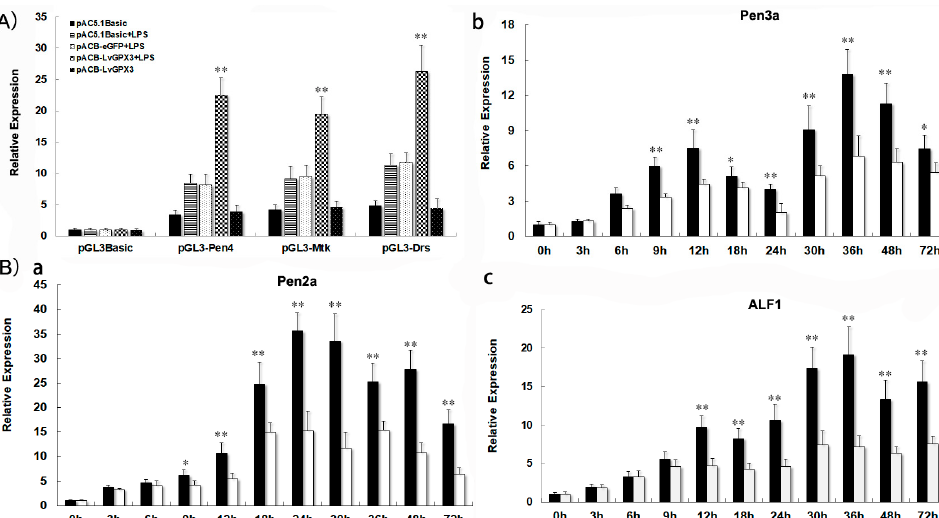
Figure 7. LvGPX3 was important for enhancing AMP expression under immune challenge. ( A ) The promoter activities of Pen4 , Mtk and Drs were measured via dual luciferase reporter gene assays. LPS was added to S2 cells at a concentration of 5 µ g/mL 6 h before cells were harvested. The bars indicate mean values ± S.D. of the luciferase activity ( n = 3). ( B ) Upon LPS treatment, inhibiting LvGPX3 decreased the expression of Pen2a ( a ), Pen3a ( b ), and ALF1 ( c ) but not Crustin . For LPS injection, each shrimp was injected with LPS at 36 h after dsRNA injection with a concentration of 240 µ g LPS dissolved in 50 µ L PBS [21]. The bars represent the mean values ± S.D. of three replicates. The statistical significance was calculated using Student’s t -test (* indicates p < 0.05, ** indicates p < 0.01).